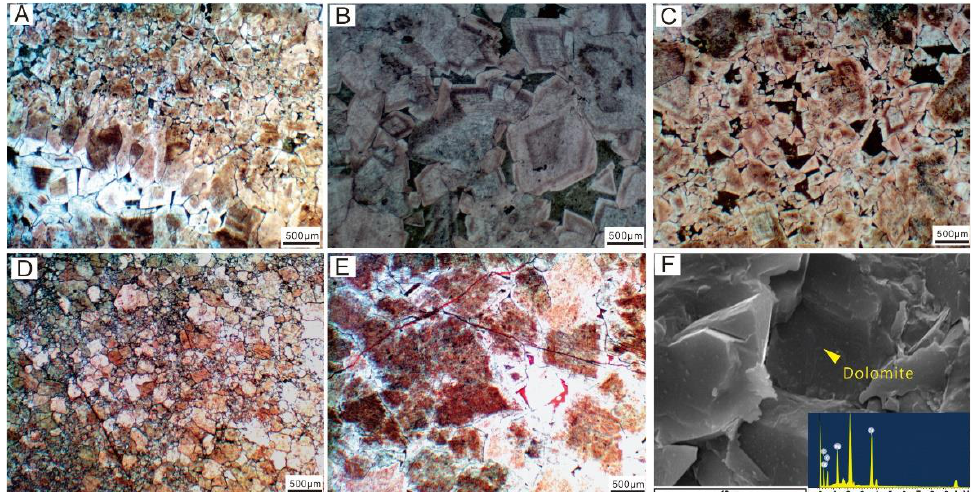
Figure 5. D3 dolomite: ( A ) rhombohedral-shaped crystals with cloudy cores and well-defined edges, well BT5, 4742.29 m, Є 3 x, under PPL. ( B ) Coarse dolomite crystals with compositional zoning, well T1, 3181 m, Є 3 x, under PPL. ( C ) Floating dolomite crystals, well BT5, 4810.65 m, Є 3 x, under PPL. ( D ) D3 dolomite with curved crystal planes and a tightly packed texture, well XH1, 5436.00 m, Є 1 x, under PPL. ( E ) Intercrystalline pores occluded by calcite, well T1, 3678.15 m, Є 3 x, under PPL. ( F ) Pores among the coarse dolomite crystal, well XH1, 5442 m, Є 1 x, under